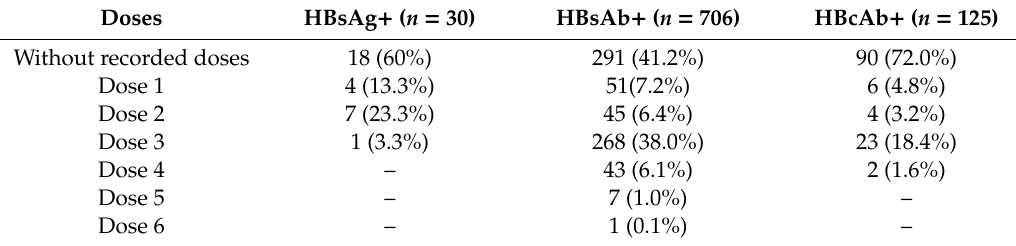
Table 7. Over-vaccination for hepatitis B of HBsAg-positive, HBsAb-positive and HBcAb-positive inmates. Doses HBsAg + ( n = 30) HBsAb + ( n = 706) HBcAb + ( n = 125) Without recorded